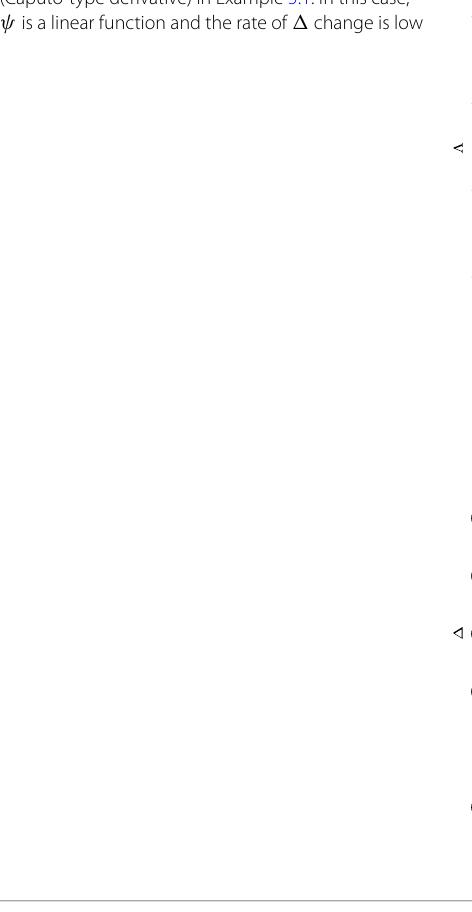
Figure 1 Graphical representation of (cid:25) and (cid:27) for η ∈ J = [0,1] and ρ = 1 , σ = 1 , where ψ 1 ( z ) = z 4 2 (Caputo-type derivative) in Example 5.1. In this case, ψ is a linear function and the rate of (cid:27) change is